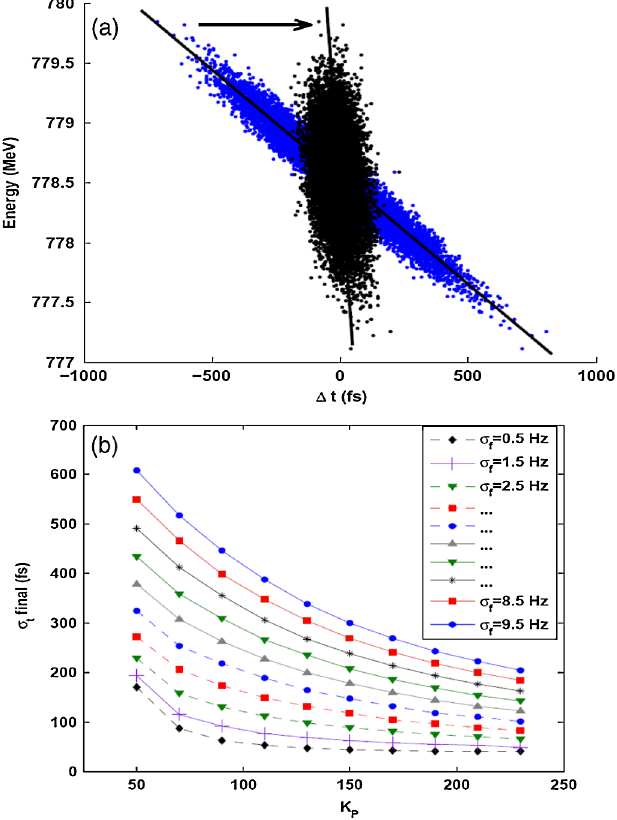
FIG. 2. (Color) Simulated time jitter of the electron beam at the linac exit of a two bunch compressor staged SRF cw linac as in [1] in dependence of the field control gain K P for different cavity rms detuning levels (cid:1) f . The initial jitter from the injector was assumed to be 600 fs, the rf phase noise 0.02 (cid:1) , and the cavity half-bandwidth 20 Hz. Plot (a) shows as an example the bunch distribution before and after a bunch compressor chicane. The lines highlight the linear energy-position correlation. Plot (b) shows the result for correlated